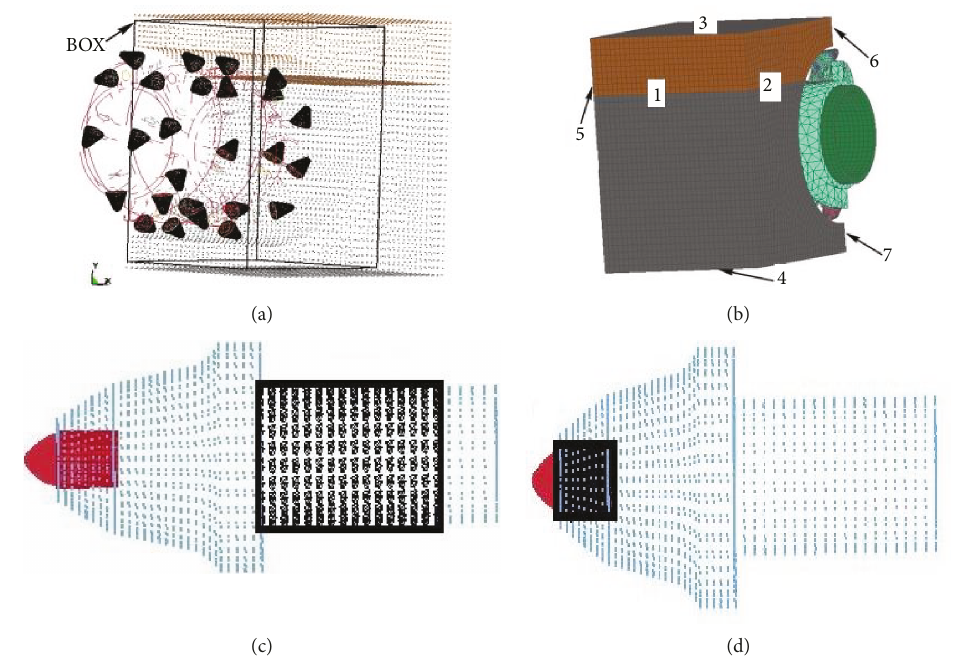
Figure 3: Boundary conditions and constraints of the